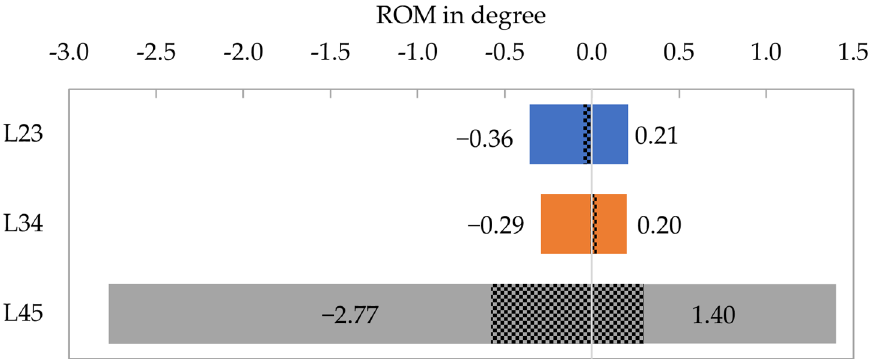
Figure 7. Range of motion (ROM) of the three spinal segments under 7.5 Nm flexion-extension loading. Positive values: flexion. Negative values: extension. The hatched area represents the neutral zone (NZ). L45: untreated control.